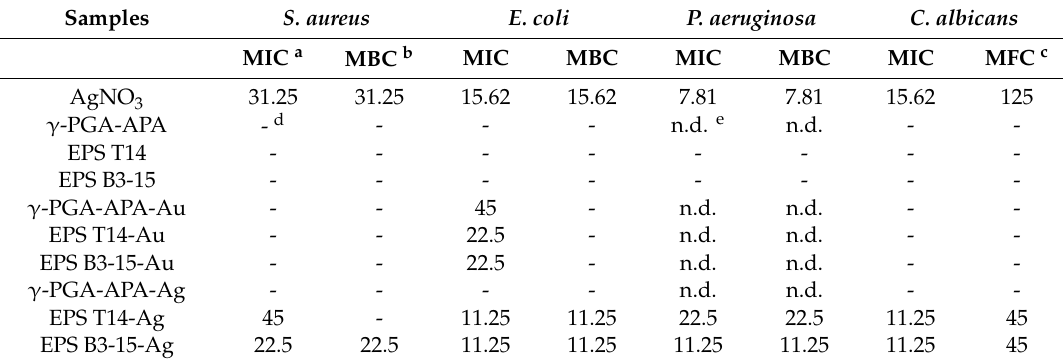
Table 2. Antimicrobial activity of EP-Au NPs and EP-Ag NPs ( µ g / mL). Samples